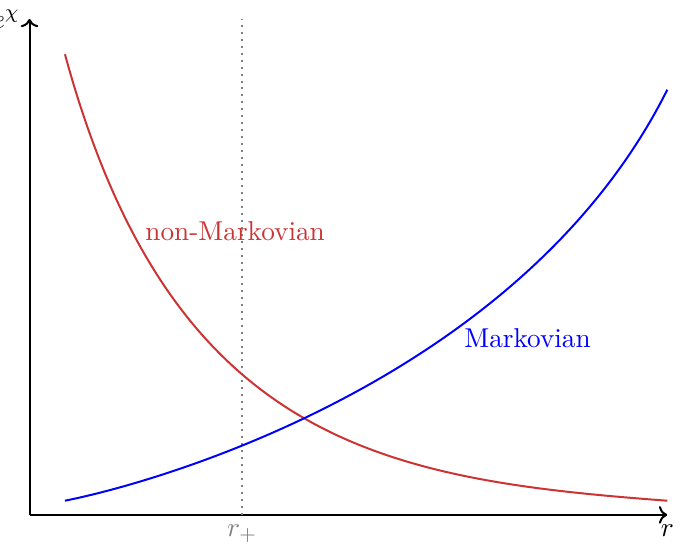
Figure 1 . A cartoon of the effective modulation of the gravitational coupling, parameterized as an effective dilaton e χ for Markovian and non-Markovian modes in a black hole geometry with a horizon at r = r +